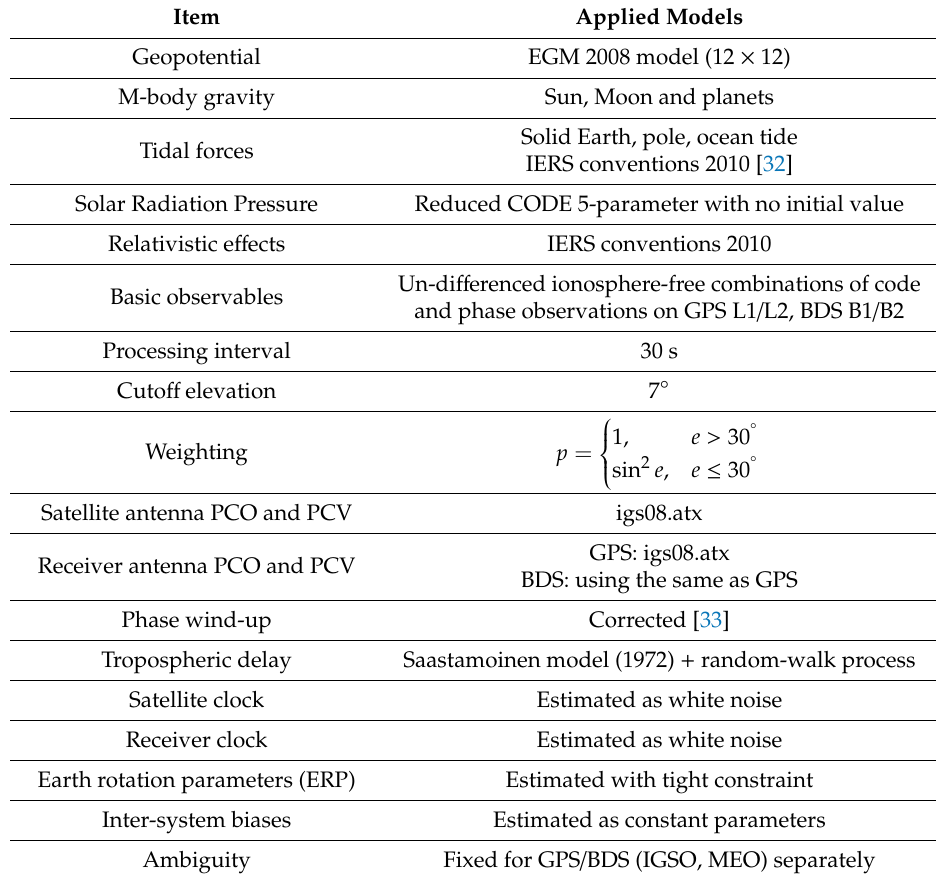
Table 1. Dynamic models and observation models used in the GPS / BDS POD